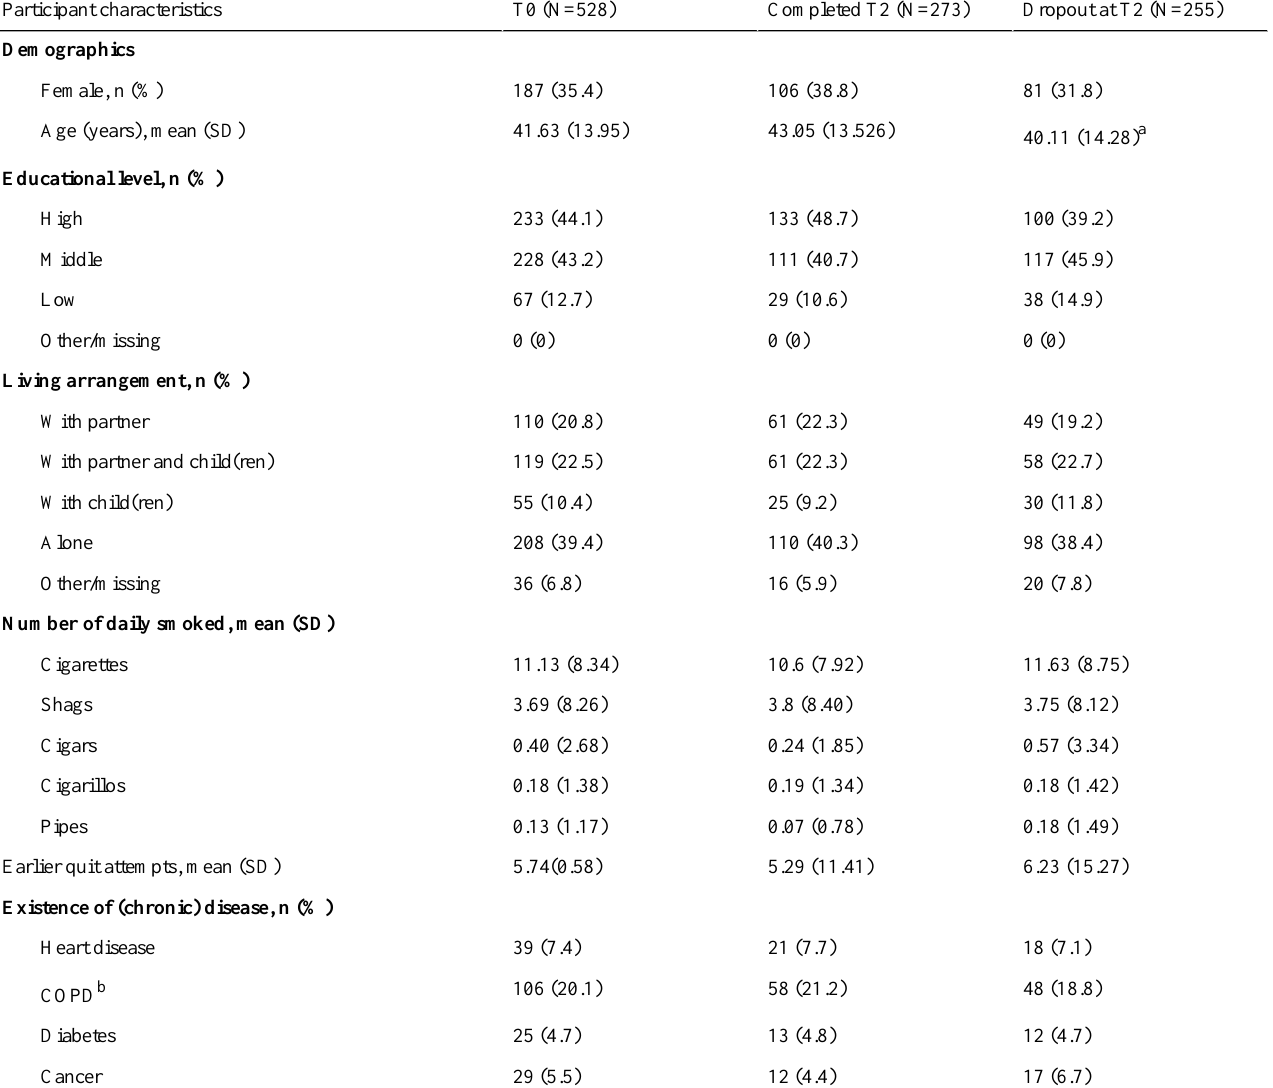
Table 1. Comparison of participants who completed the study with those who dropped